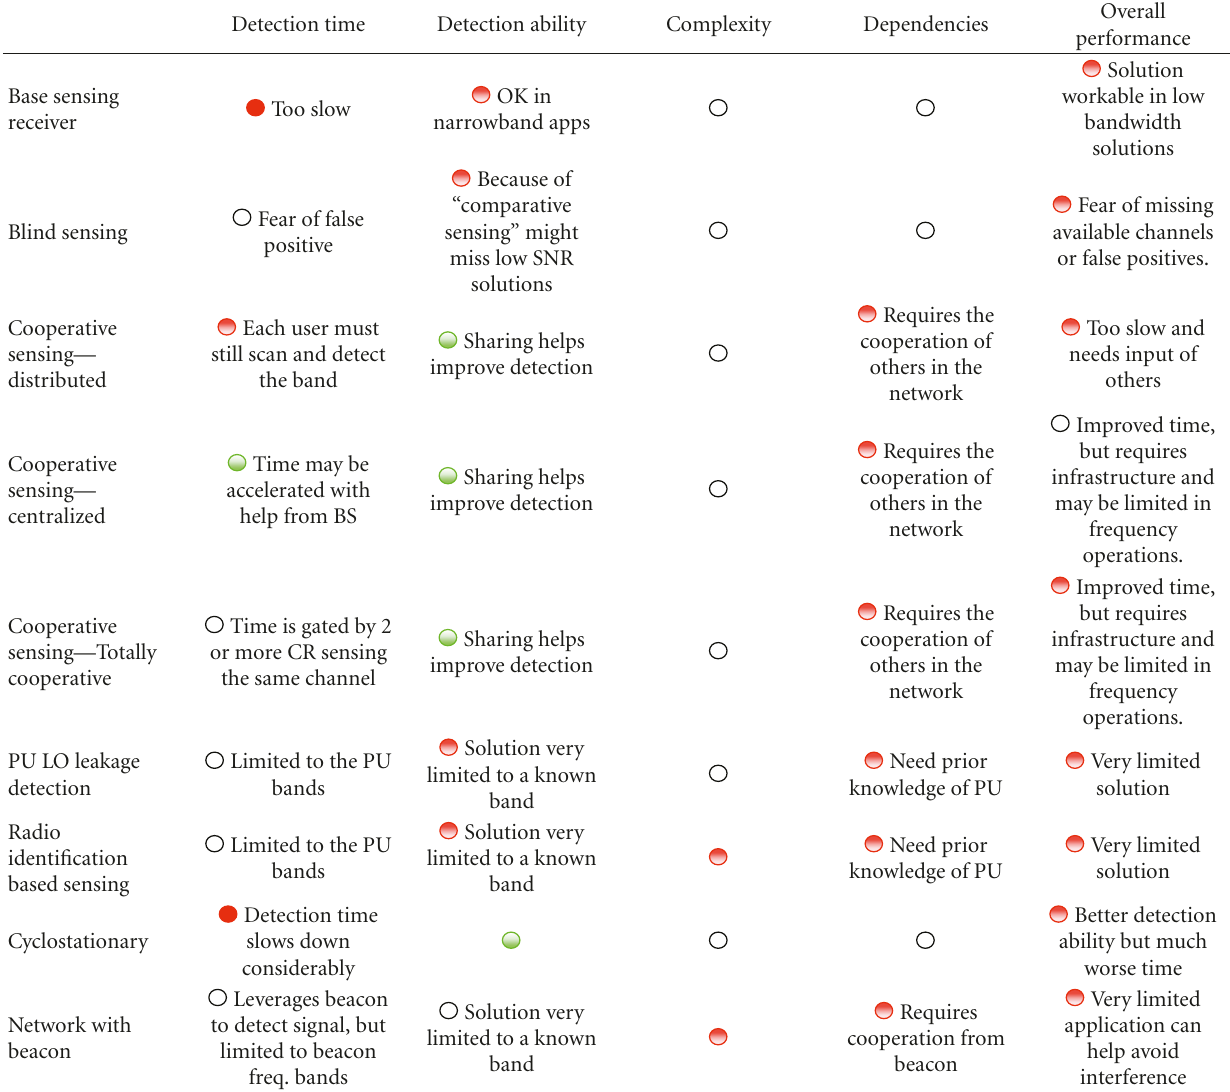
Table 1: Prior work